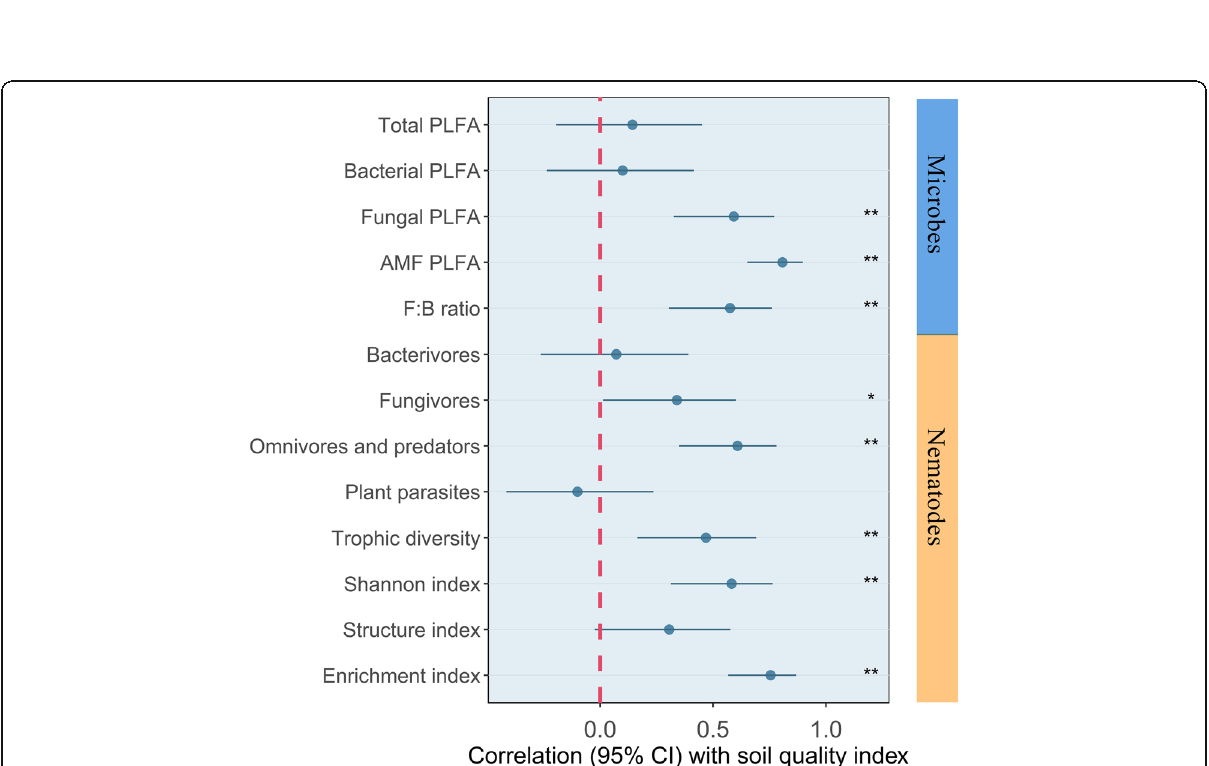
Fig. 5 Pearson correlation analysis between soil quality index and indices of soil microbial and nematode communities